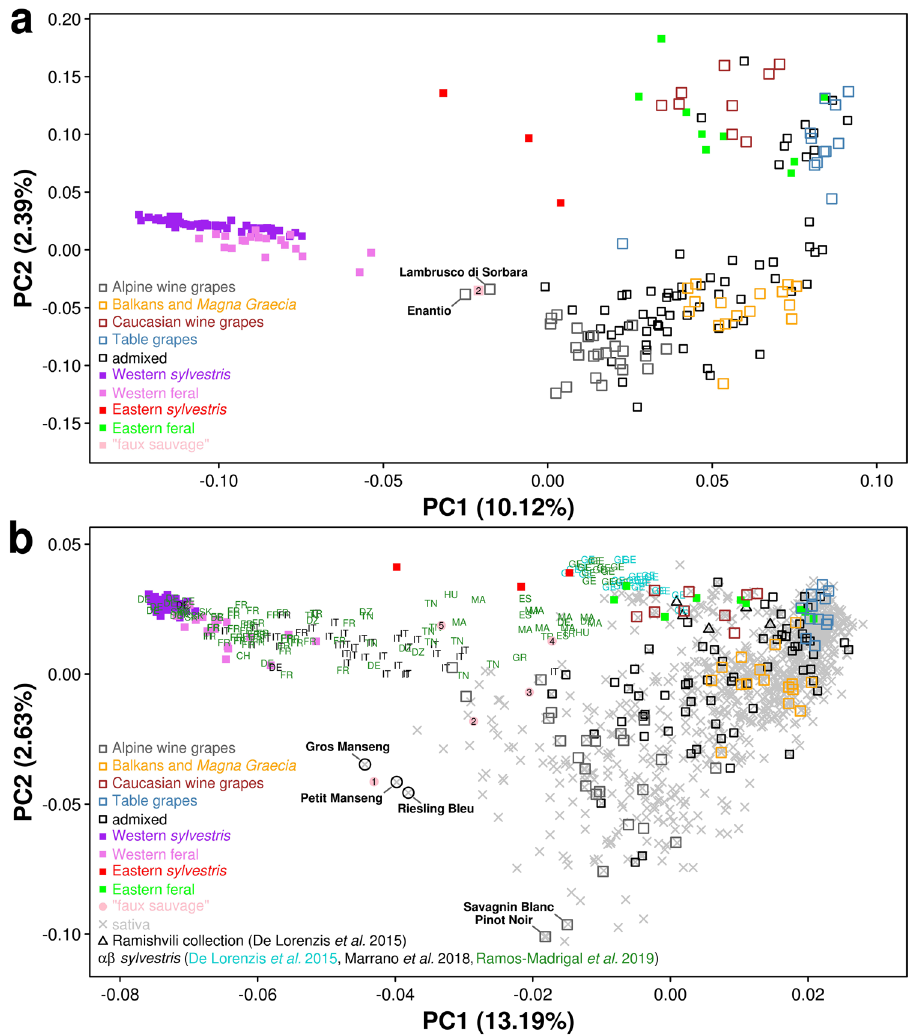
Fig. 3 Principal component analysis (PCA) in the WGS panel (a) and in the diversity panel (b). a PCA of 204 V. vinifera whole genome resequenced genotypes based on 7.9 M SNPs. b PCA of 1445 V. vinifera genotypes based on a subset of 6357 pre-ascertained SNPs in the diversity panel and in common with the WGS panel. Sequenced samples are indicated as open (cultivated varieties) and solid (wild accessions) squares. Additional cultivated varieties are indicated as gray crosses in b . Samples with uncertain assignment in their literature reports are reported as “ faux sauvage ” : 1, sylvestris